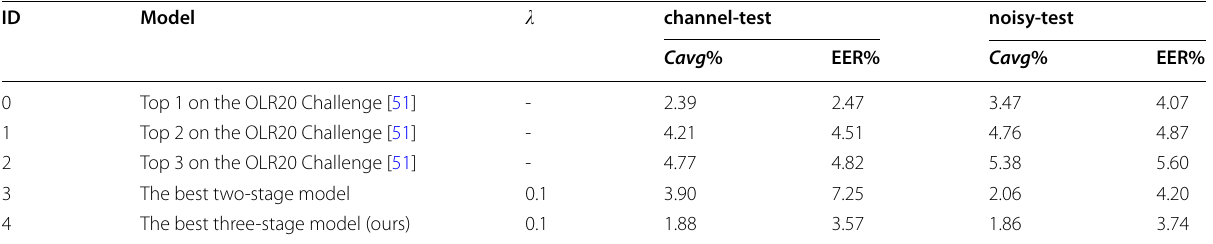
Table 6 The comparison of our best model with the best two-stage model and the top three models on the OLR20 challenge ID Model (cid:31)